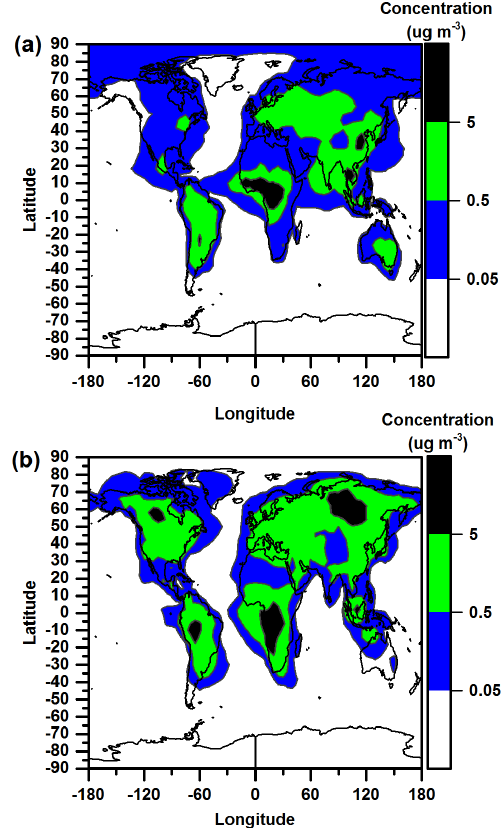
Figure 1. Monthly averaged total organic aerosol concentrations (colour scale) at the Earth’s surface in (a) January and (b) July, as calculated using GEOS-Chem.